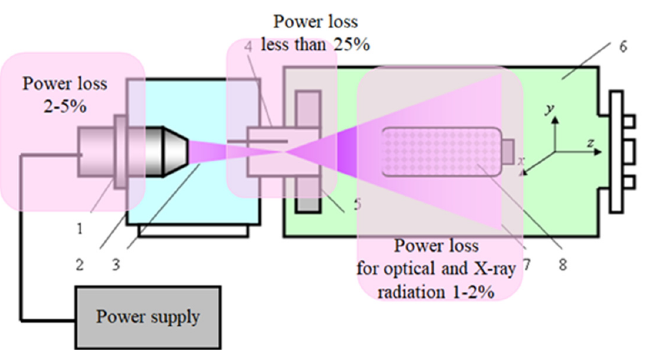
Figure 6. Some estimations of Electron Beam-Plasma Reactors efficiency: 1—electron-beam gun, 2—high vacuum chamber, 3—electron beam, 4—injection window, 5—electromagnetic scanning system, 6—working chamber, 7—EBP cloud, 8—mixer with polysaccharide powder to be treated.